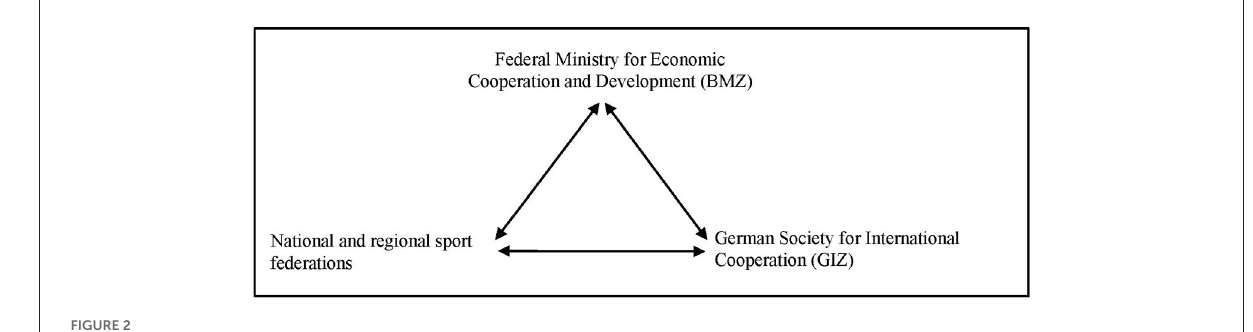
FIGURE2 Organizations included in the